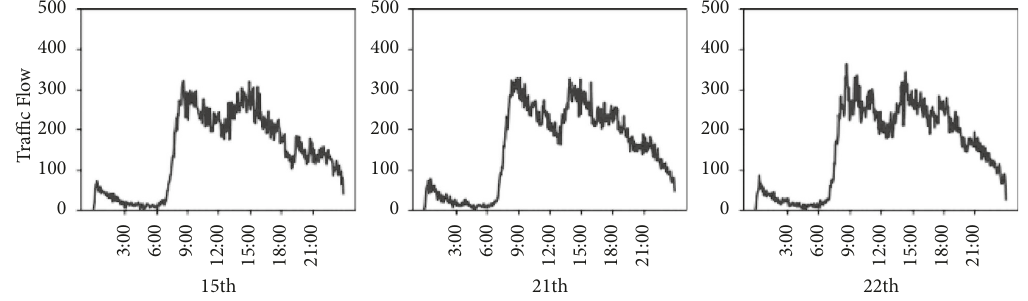
Figure 5: Results of the traffic flow statistics